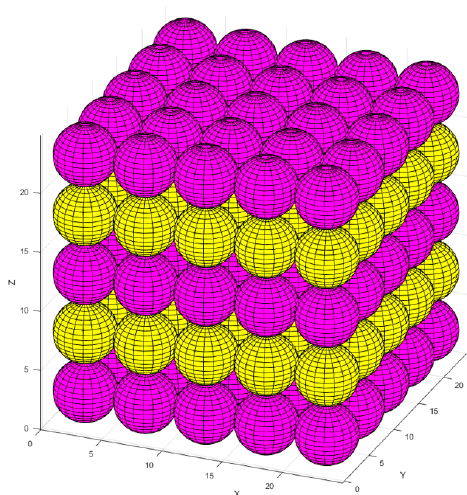
Figure A1. A close-up view of Figure 2a, representing the solid metakaolinite phase (aluminate units as yellow and silicate units as magenta).